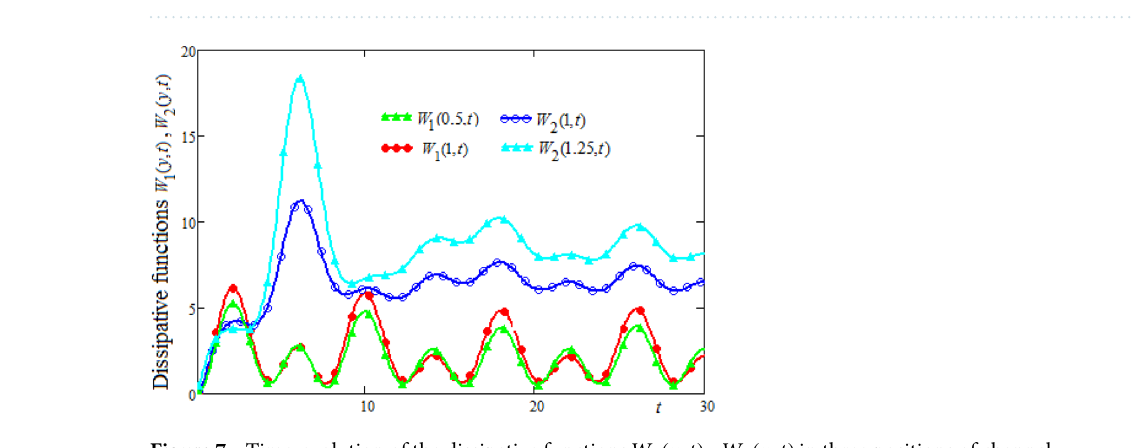
Figure 6. The profiles of dissipative functions W 1 ( y , t ) , W 2 ( y , t ) versus y for different values of the time t.